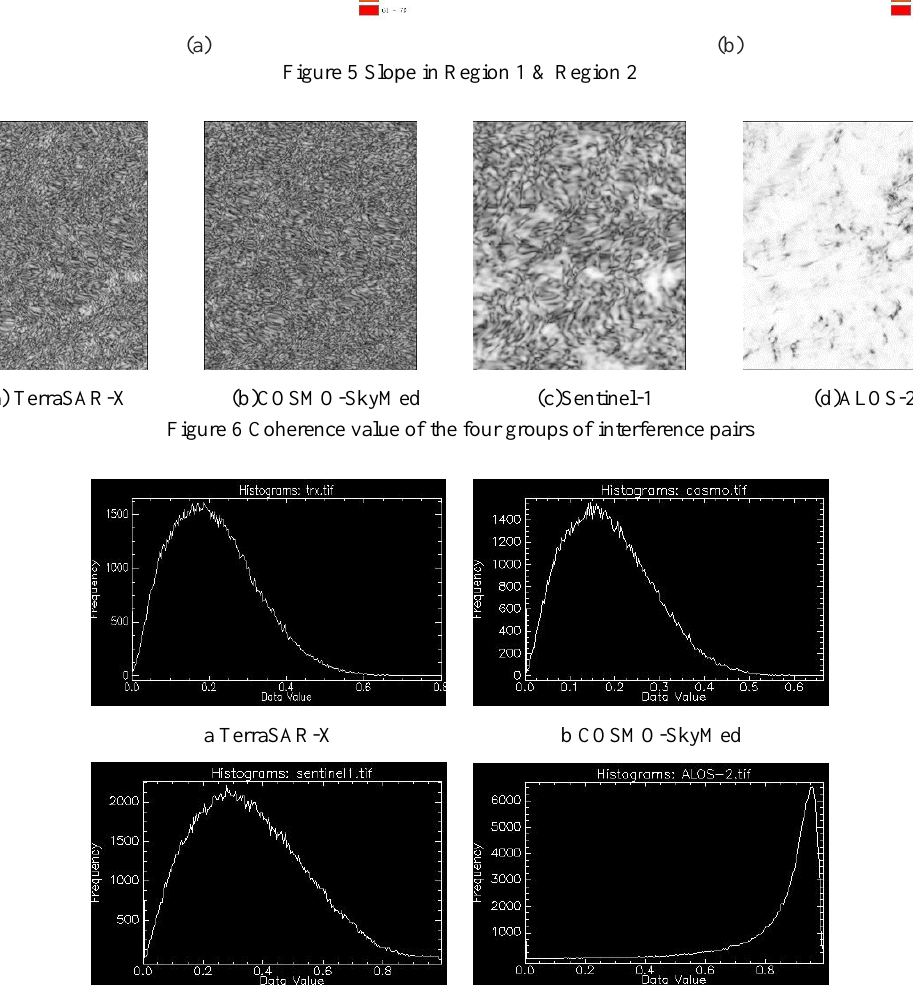
Figure 5 Slope in Region 1 & Region 2